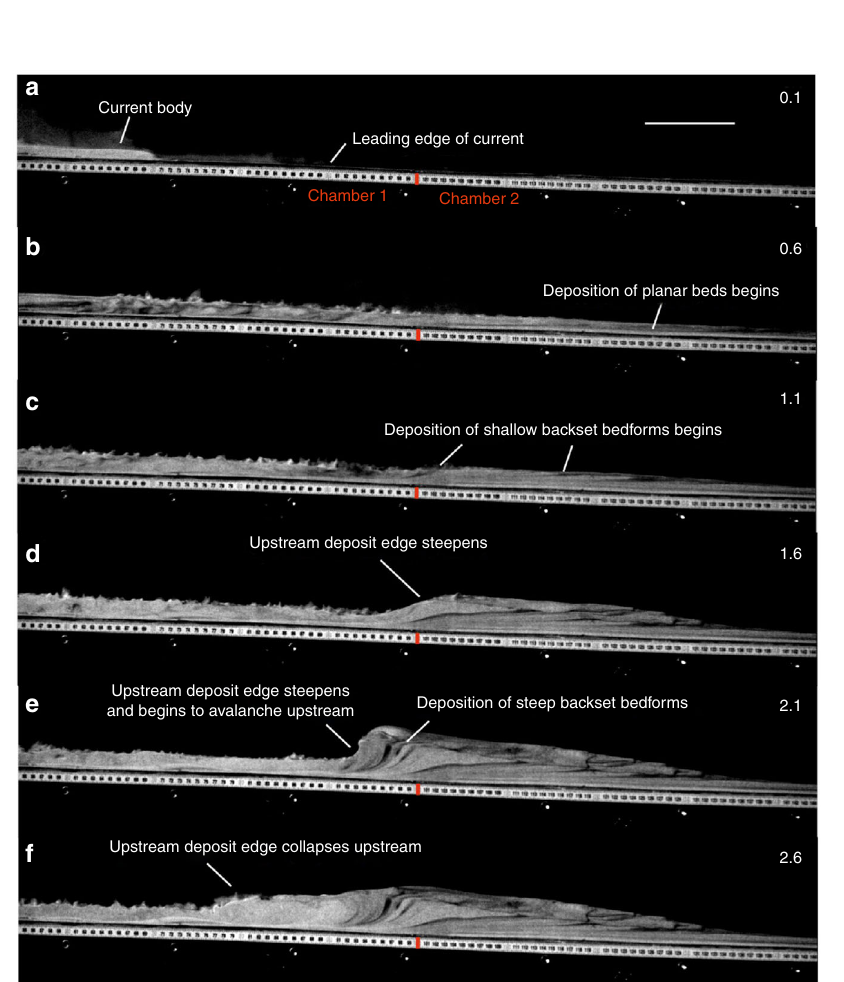
Fig. 3 Timelapse of an experimental granular current. Scale bar = 10 mm. a an experimental granular current before deposition begins. b – c deposition is triggered by the current passing above a chamber aerated at 0.93U mf to one unaerated. d – e the upstream edge of the deposit steepens, forming steep backset bedforms. f the upstream edge of the deposit collapses. Number in the top right of the frames is the time in seconds since the current entered the fi rst ( N F ). The Froude number ( Fr ) represents the ratio of kinetic to potential energy (Eq. (1)). = 2 ð 1 Þ Fr ¼ U = gH ð Þ 1 Where U = current velocity, g = gravity and H = current thick- ness. The Friction number ( N F ) is the ratio of frictional to viscous stresses and is de fi ned as Bagnold number/Savage number 54,55 . The Savage number ( N S , Eq. (2)) is the ratio of collisional stress to frictional stress 55,56 , and the Bagnold number ( N B , Eq. (3)) is the ratio of collisional stress to viscous fl uid stress 55,57 .